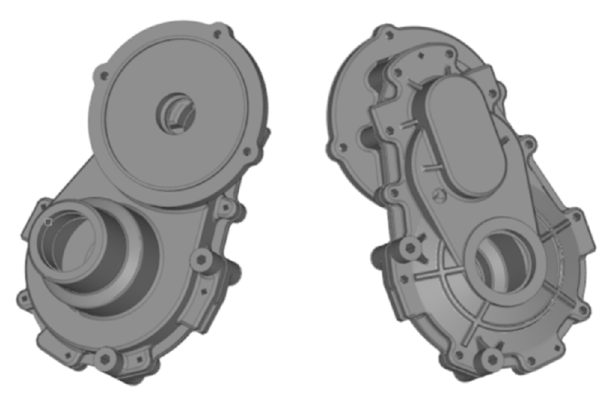
Figure 11. Original shape of the gearbox housing.